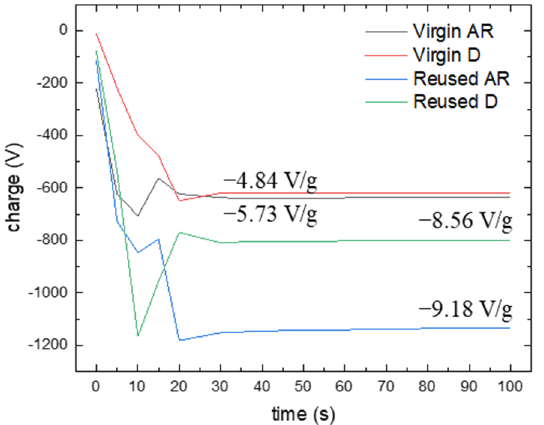
Figure 8. Electrostatic charge measurement of virgin and reused powder in as-received (AR) and dried (D) condition.